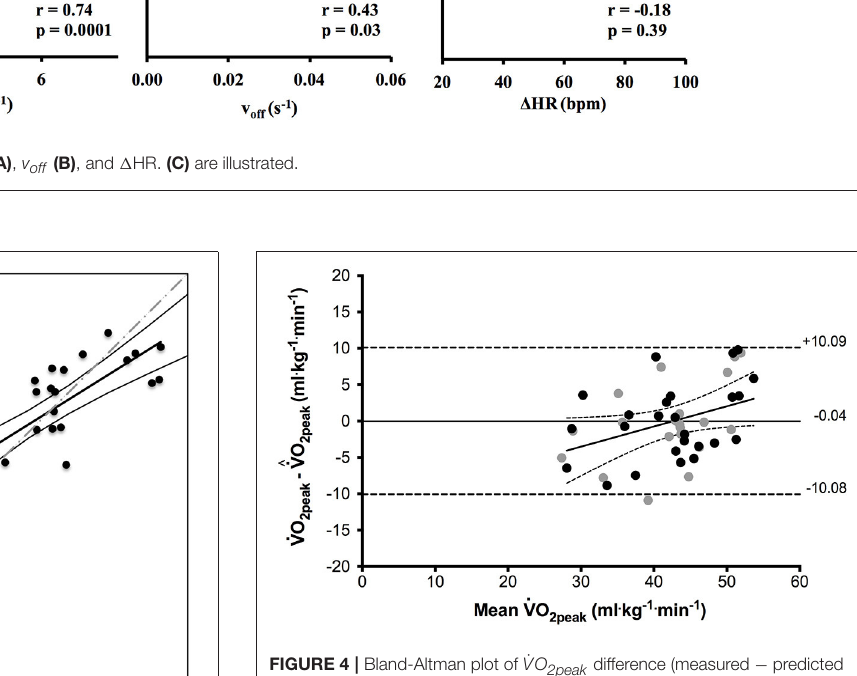
FIGURE 4 | Bland-Altman plot of ˙ VO 2peak difference (measured − predicted values) vs. mean ˙ VO 2peak (black circles). Solid line (average bias = − 0.04 ml . kg − 1. min − 1 ); dashed line indicates 95% limits of agreement. The trend line equation expresses y = 0.28x − 11.9, with r = 0.40 ( p = 0.04) with confidence intervals (95%). Gray circles: predicted values based on 5s average of HR time course (see section